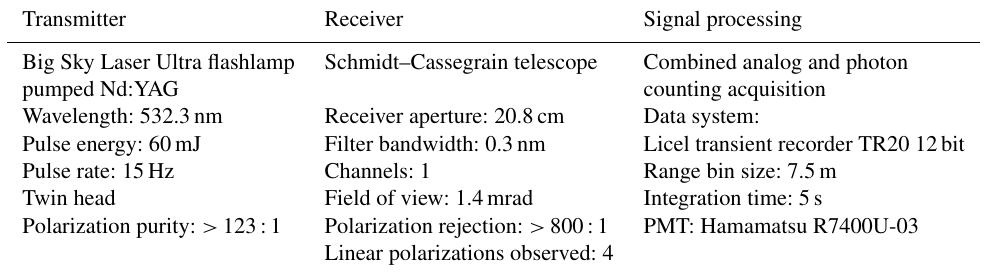
Table 1. CAPABL current system specifications. Polarization purity and polarization rejection are measured quantities. Polarization purity is measured with a 100000:1 Glan–Taylor polarizer.